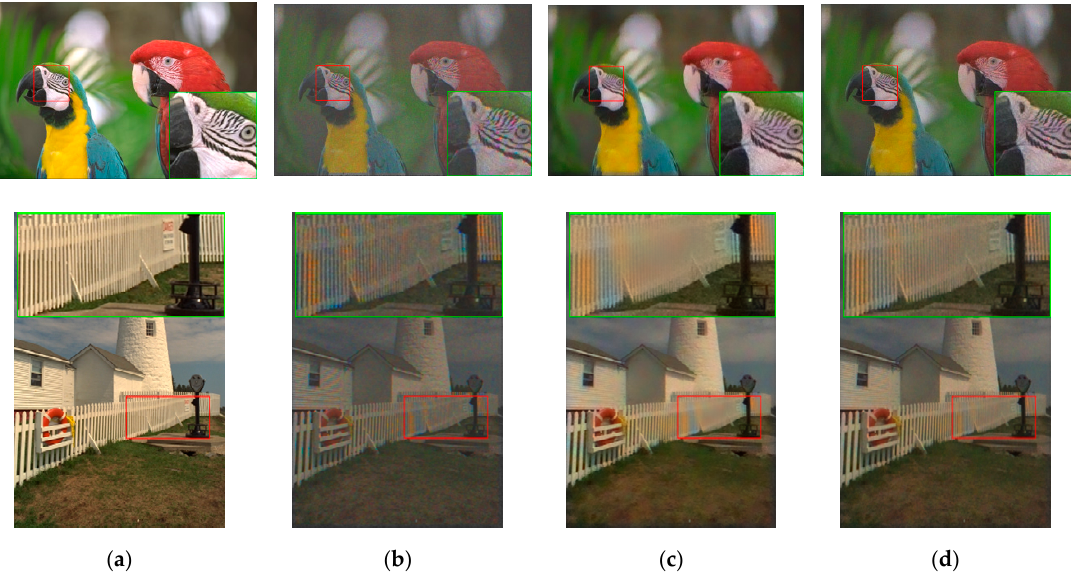
Figure 9. Visual comparison of three high performing demosaicing algorithms at 10 dBs SNR (Poisson noise). The top row is the bird image and the bottom row is the lighthouse image. ( a ) Ground Truth; ( b ) Standard; ( c ) GFPCA; ( d ) F3.